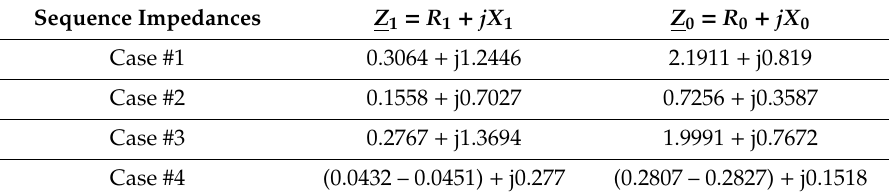
Table 12. The p.u.l. posit. and zero sequence impedances in Ω with MCA. Sequence